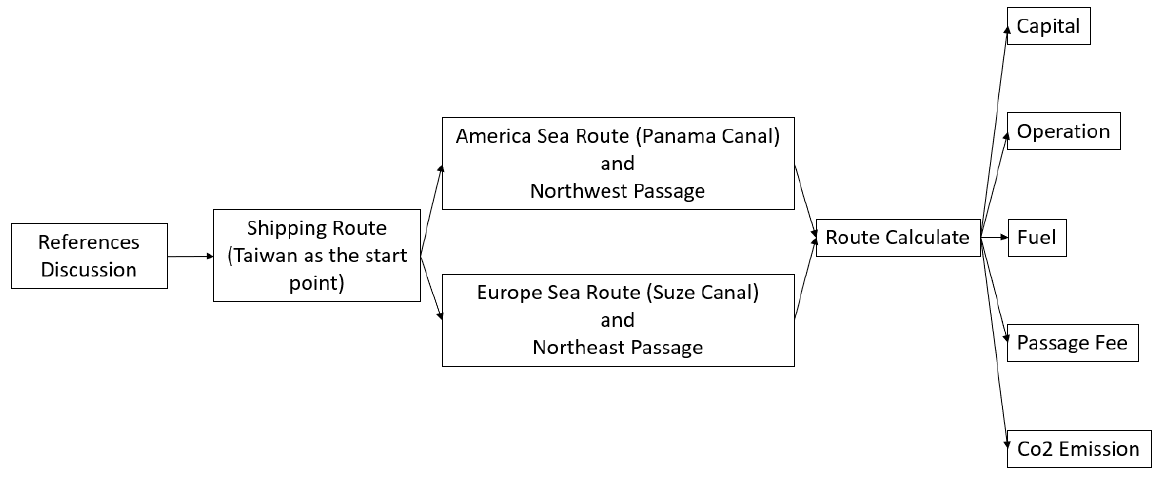
Figure 1. The block diagram of the procedure.